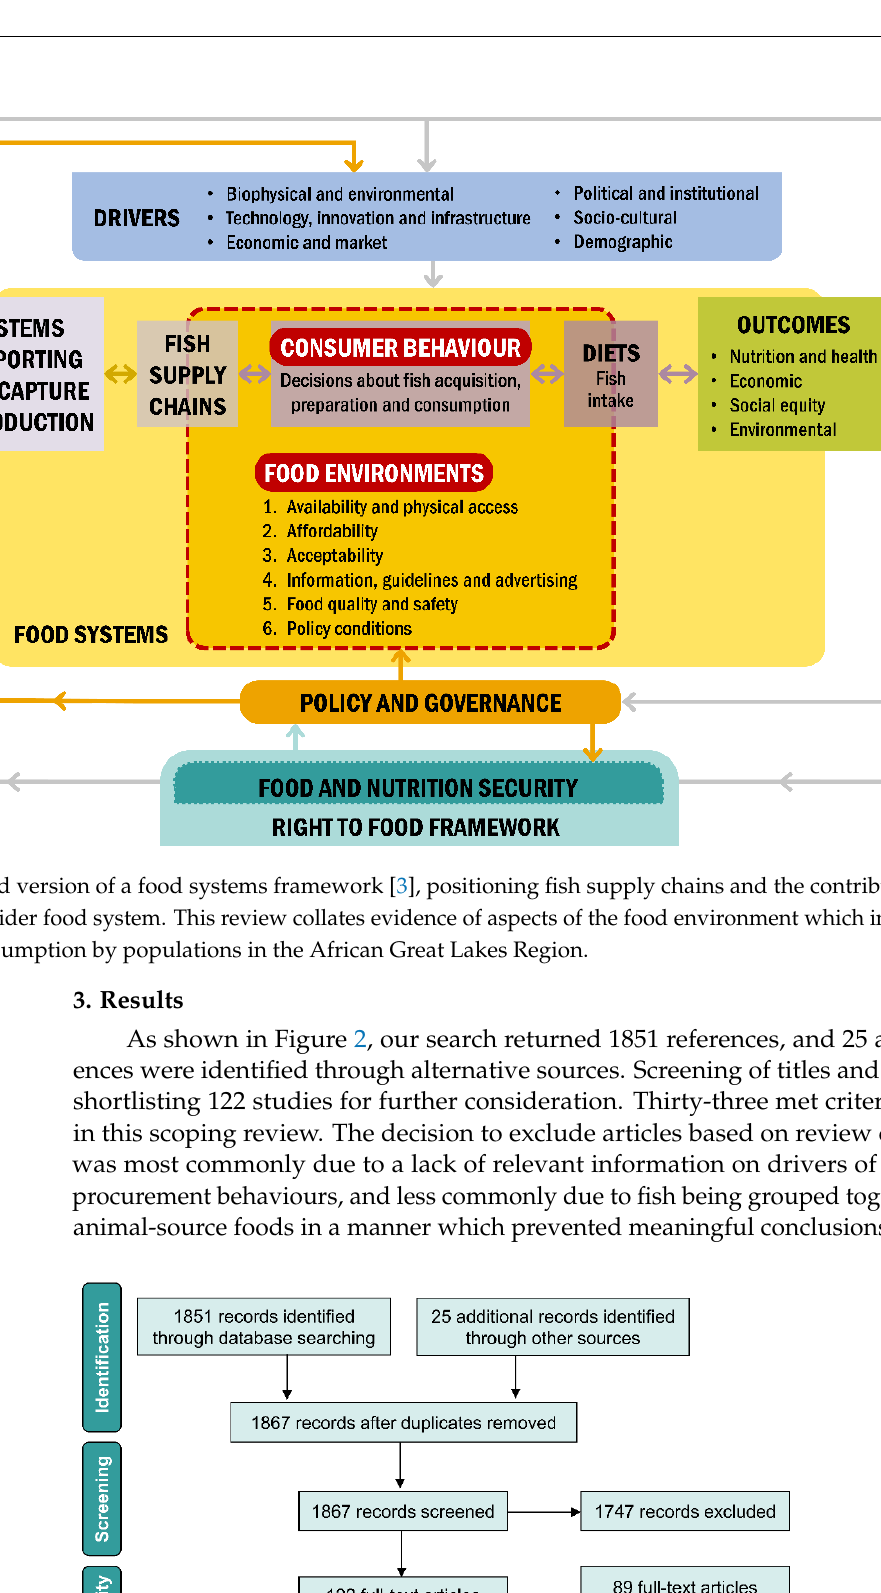
Figure 2. Studies reviewed and excluded at each stage.